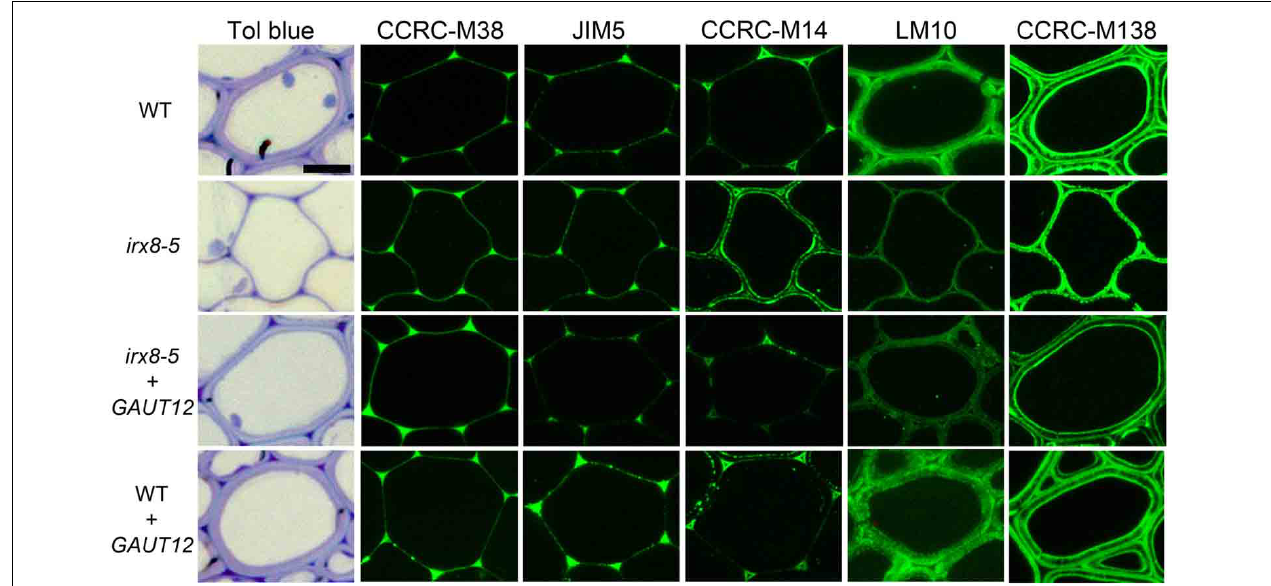
FIGURE 8 | Immunolabeling of interfascicular fiber cells from basal stems of 6-week-old wild-type (WT), irx8-5 , irx8-5 + GAUT12 , and WT + GAUT12 plants with anti-pectin and anti-xylan antibodies. CCRC-M38 recognizes un-esterified HG, JIM5